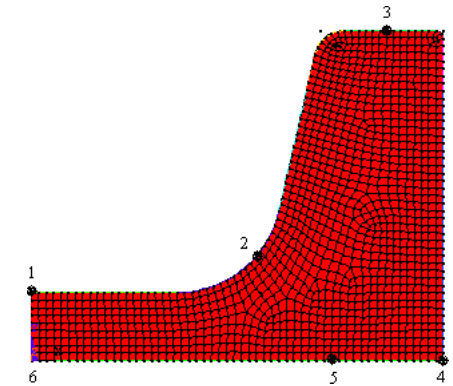
Figure 10: Finite-element grids and some representative points.